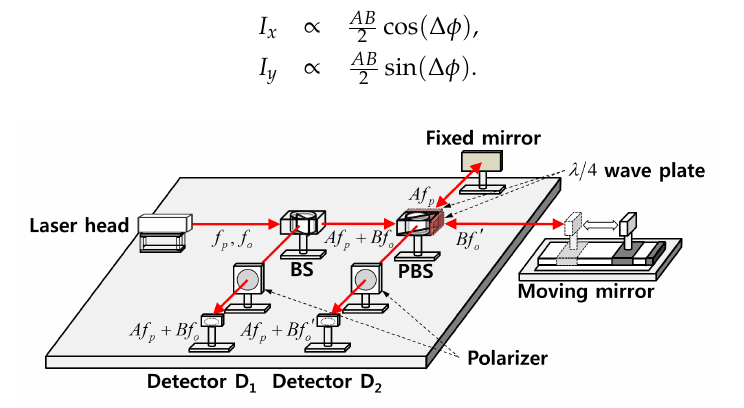
Figure 1. Schematic diagram of seismic wave measurement system using a laser